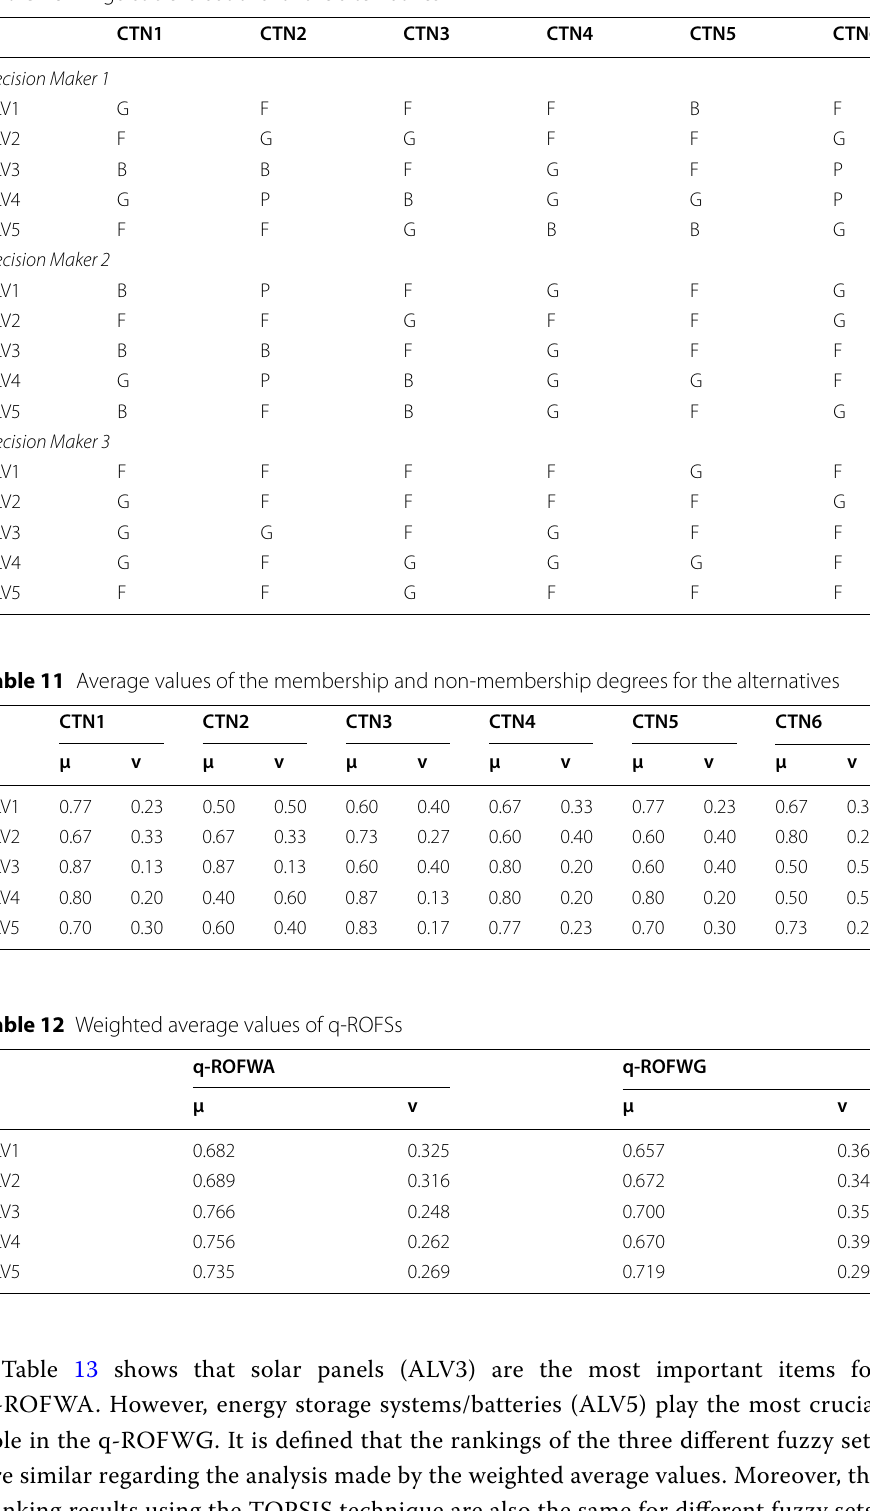
Table 10 Linguistic evaluations for the alternatives